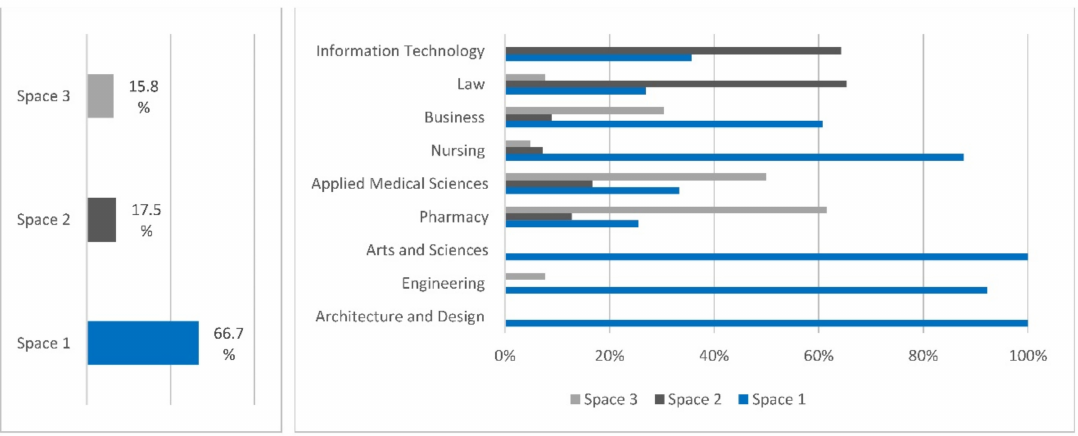
Figure 12. Preferred open space in the university campus.